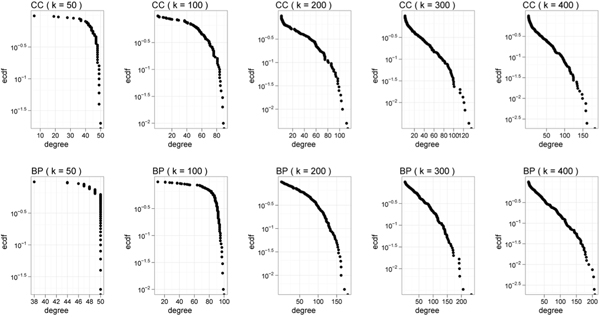
Connectivity of functional clusters in H. sapiens network. Functional cluster degree CDF plots for BP and CC summaries at varying cluster granularity. Plots are on a semi-log scale.